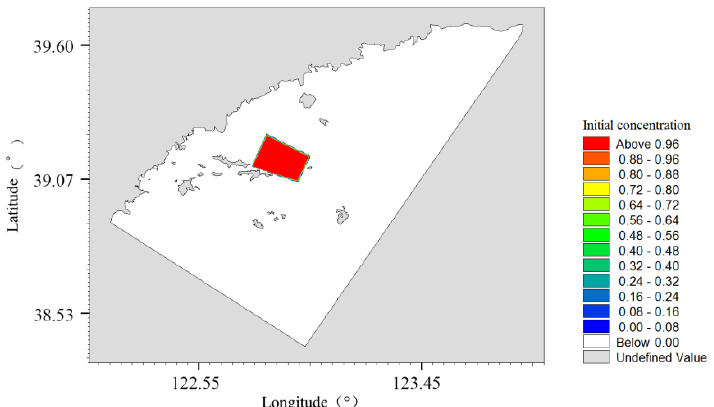
Figure 13. Tracer concentration distribution at the initial time point (the red area is the statistical area for water exchange rate).